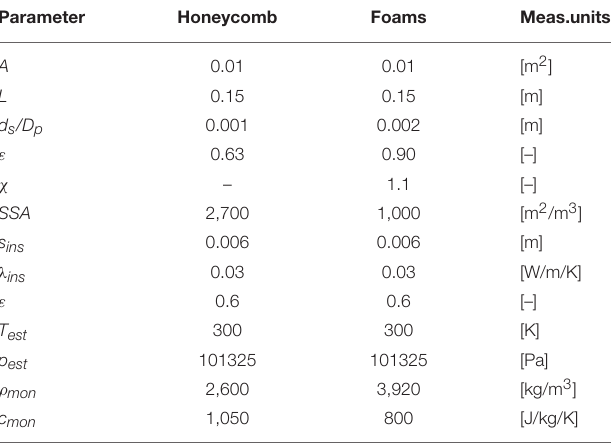
TABLE 2 | Values of parameters assumed for the catalysts models. Parameter Honeycomb Foams Meas.units